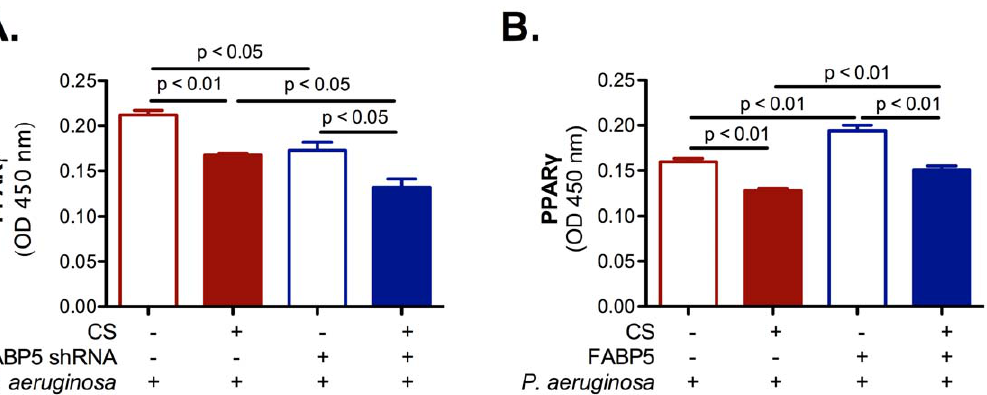
Figure 7. FABP5 expression modulates PPAR- c activity. A. FABP5 down regulation significantly decreases PPAR- c activity in primary NHBE cell cultures. B. FABP5 up regulation significantly increases PPAR- c activity in primary NHBE cell cultures. FABP5 shRNA 2 indicates cells that were knocked down for Firefly luciferase. FABP5 shRNA + indicates cells that were knocked down for FABP5. FABP5 2 indicates cells overexpressing GFP. FABP5 + indicates cells overexpressing FABP5. Data are representative of 3 independent experiments and are expressed as mean 6 SEM.